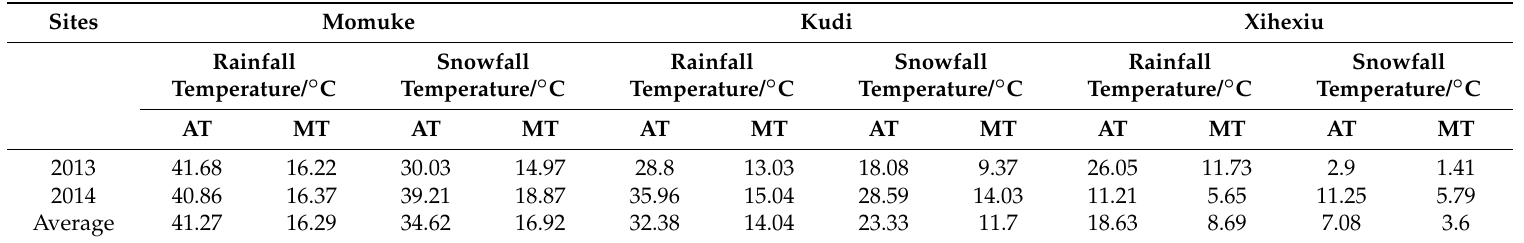
Table 1. The temperature conditions of rain and snow separation in climatic